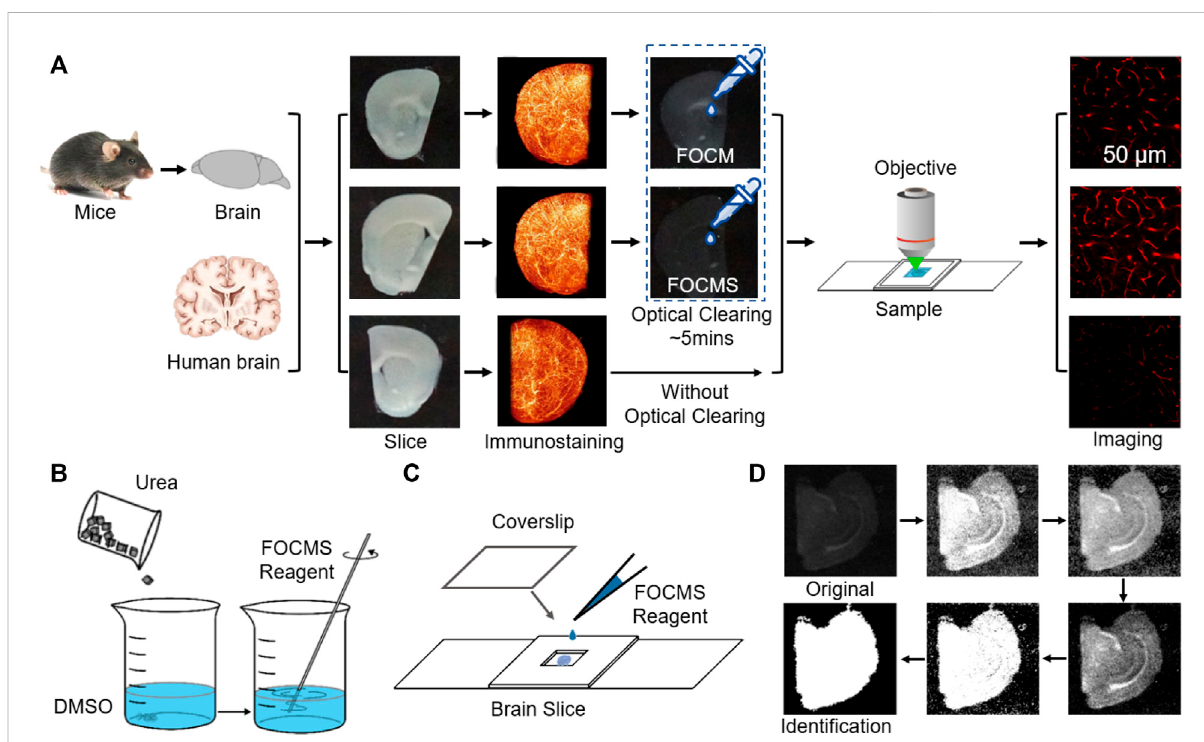
FIGURE 1 FOCMS used for immunostaining imaging and tissue recognition. (A) Optical imaging process including brain preparation, slicing, immunostaining, optical clearing and imaging. (B) Reagents preparation of FOCM. (C) Biological sample clearing and mounting procedure before optical imaging. (D) Brain slice range recognition process. The six images are results of normalized, enhancement, pre-recognition, differentiated processinganddenoising,binarizationofcustomizedthresholdandremovingisolatednoise,respectively.White:brainarea,black:background. The sum of white pixels is the area of the brain